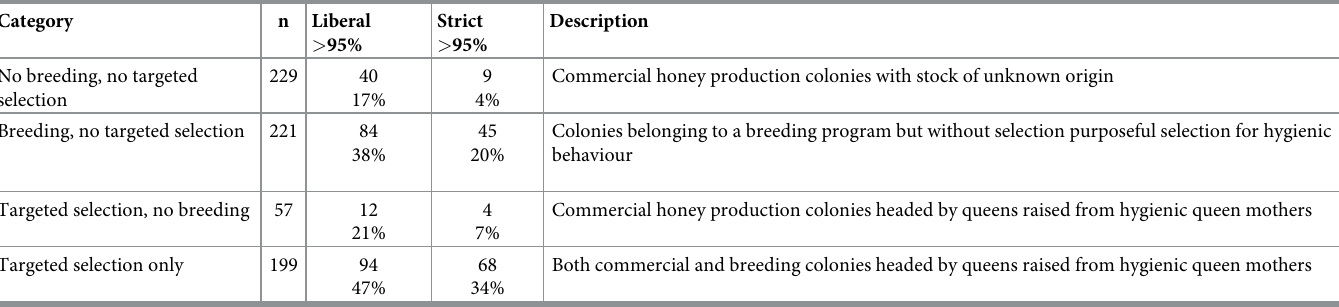
Table 1. Summary of colonies included in the survey of hygienic behaviour in Australia 2014–2016.